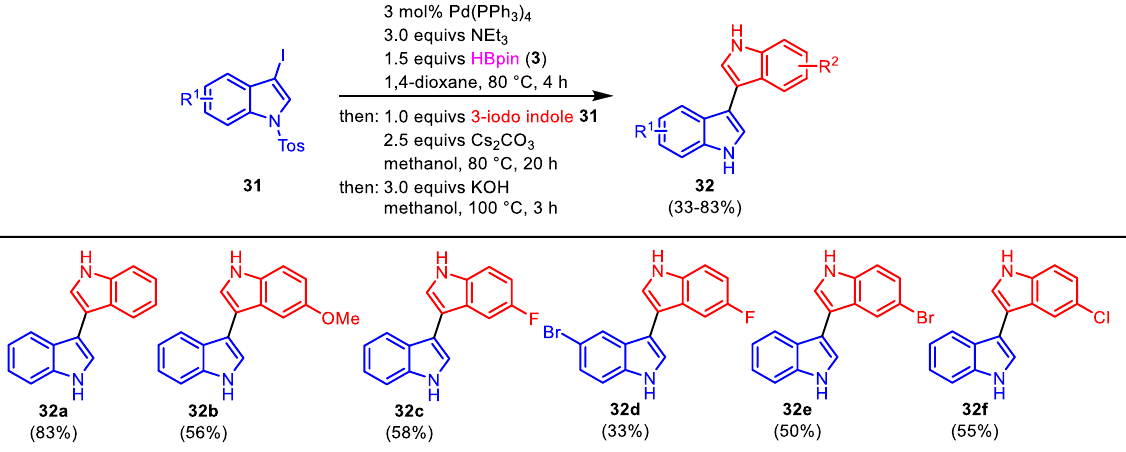
Figure 19. One- pot MBSC synthesis of 3,3‘ -biindoles 32 by Tasch et al. [50].